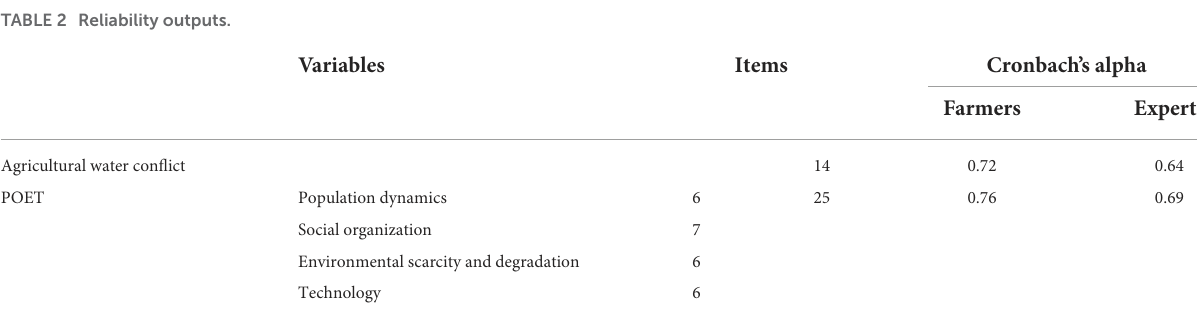
TABLE 2 Reliability